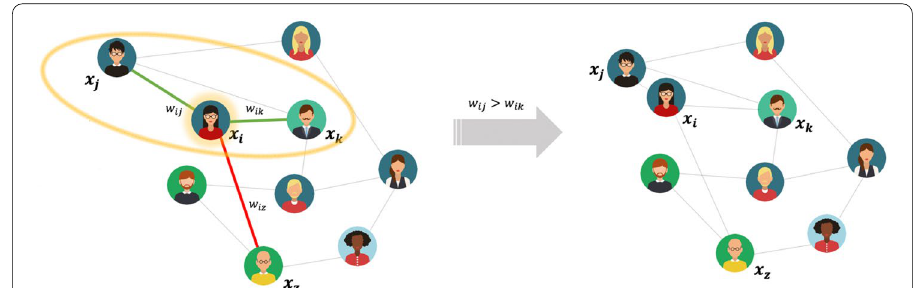
Fig. 1 Weight example. Opinion x i is influenced by the opinions of agents with the opinion more similar to its opinion; e.g., the agents in the yellow elliptical. At the end of the interaction, x i approaches the opinions of the agents with heavier weights (as visually shown x i change of position)